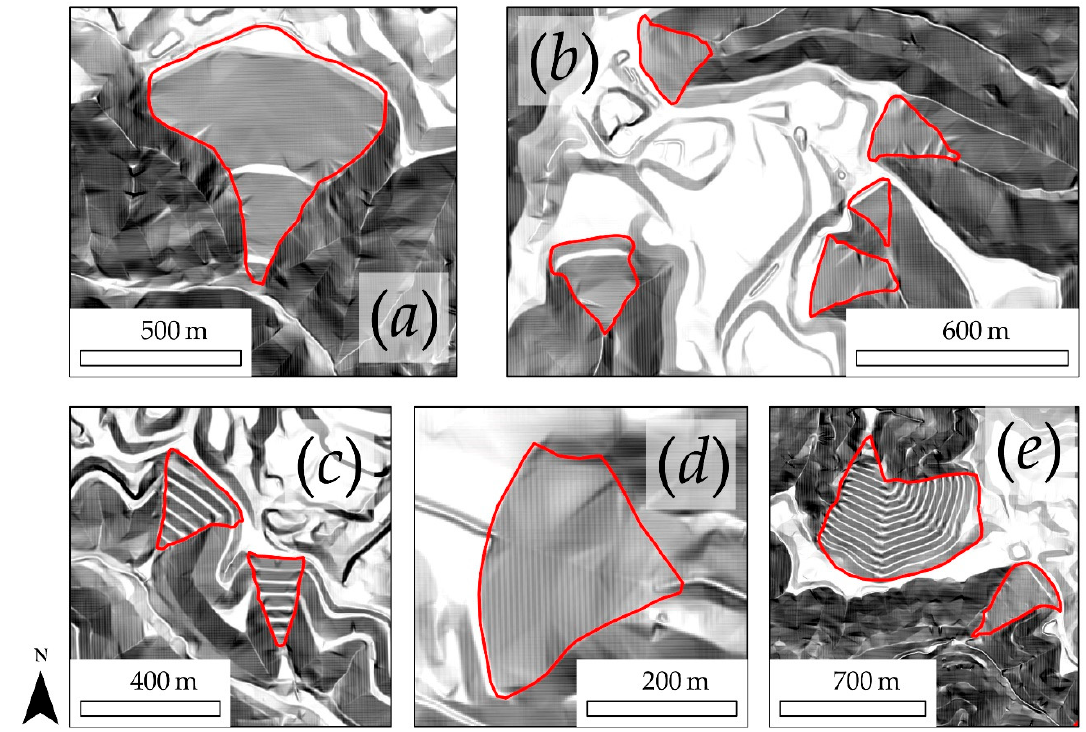
Figure 8. ( a ) Through ( e ) Examples of digitized valley fills as represented in the photogrammetric data. Table 5. Area- and fuzzy area-based error